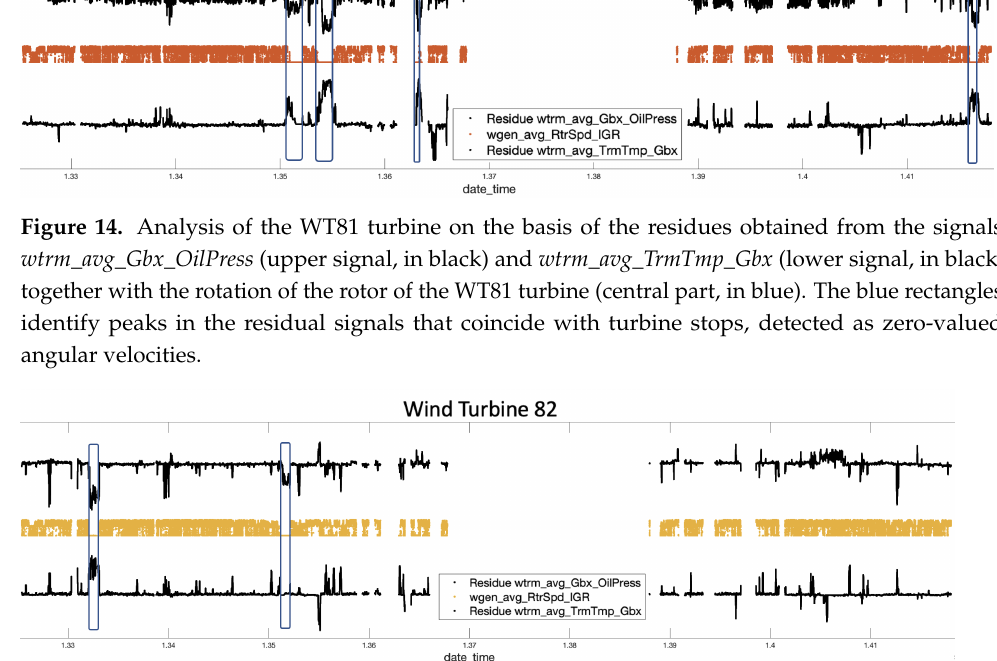
Figure 15. Analysis of the WT82 turbine on the basis of the residues obtained from the signals wtrm_avg_Gbx_OilPress (upper signal, in black) and wtrm_avg_TrmTmp_Gbx (lower signal, in black) together with the rotation of the rotor of the WT82 turbine (central part, in blue). The blue rectangles identify peaks in the residual signals that coincide with turbine stops, detected as zero-valued angular